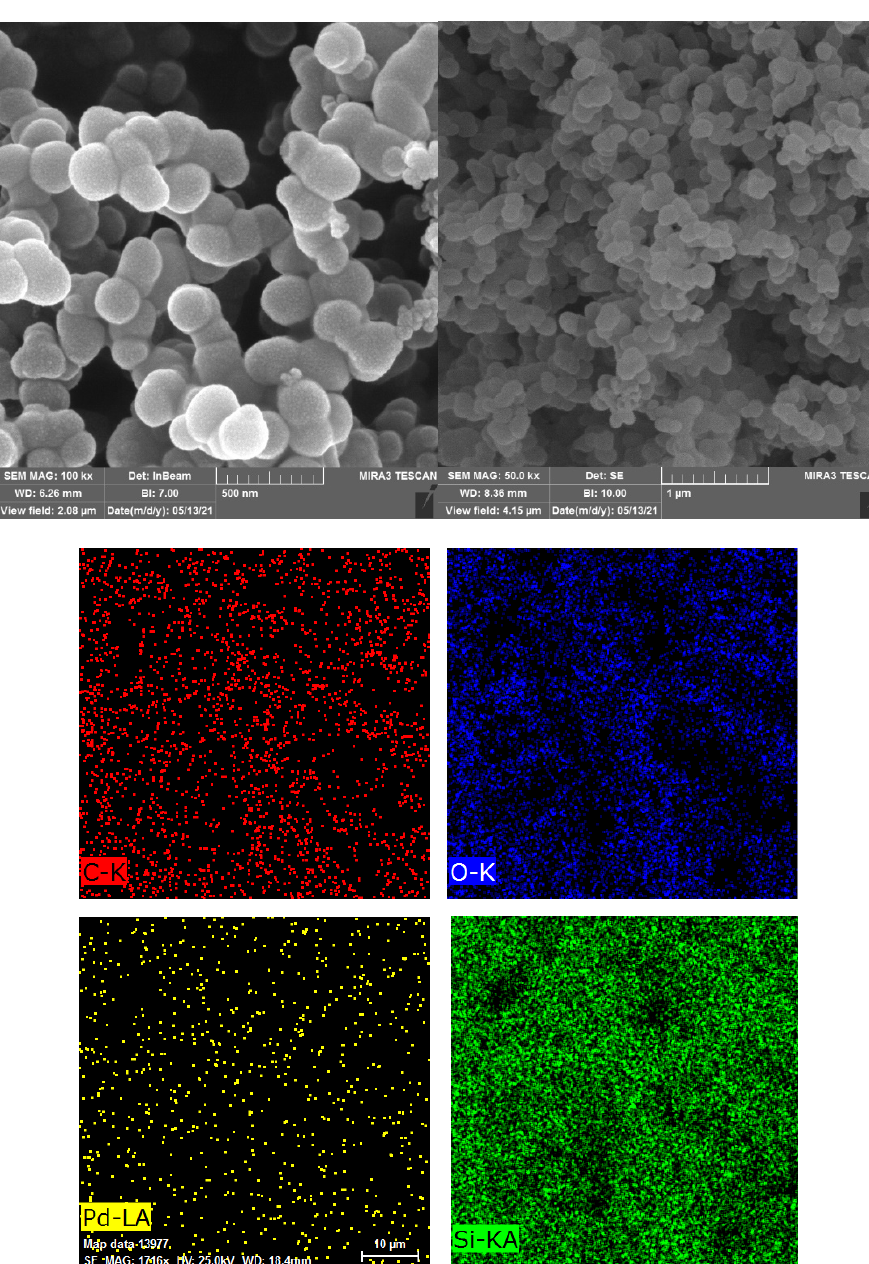
Figure 6. Scanning electron microscopy and elemental mapping of Pd@C − PS.